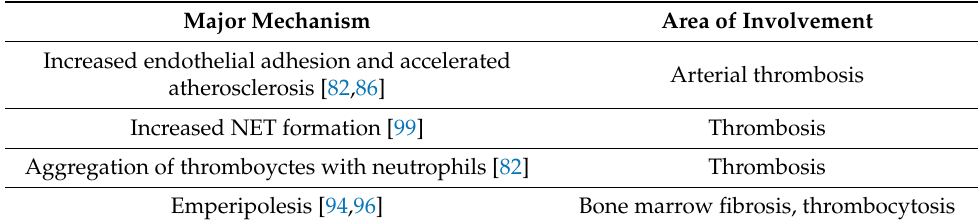
Table 2. Roles of neutrophilic granulocytes and leukocytes in